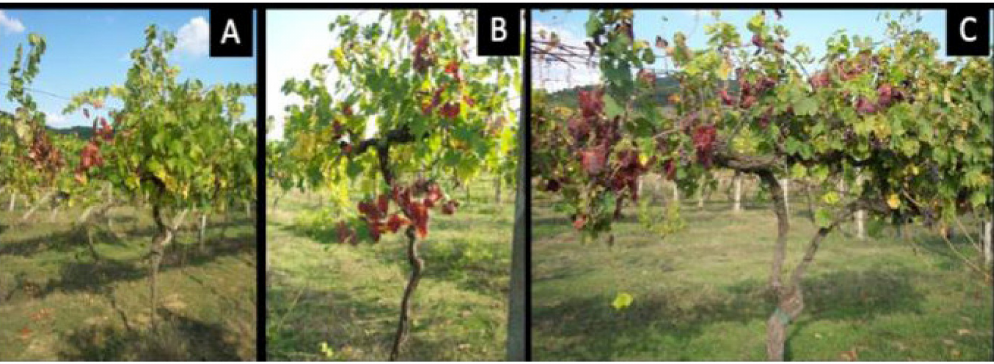
Figure 1. Grapevine classified in the symptom severity class 1 ( A ); class 2 ( B ) and class 3 ( C